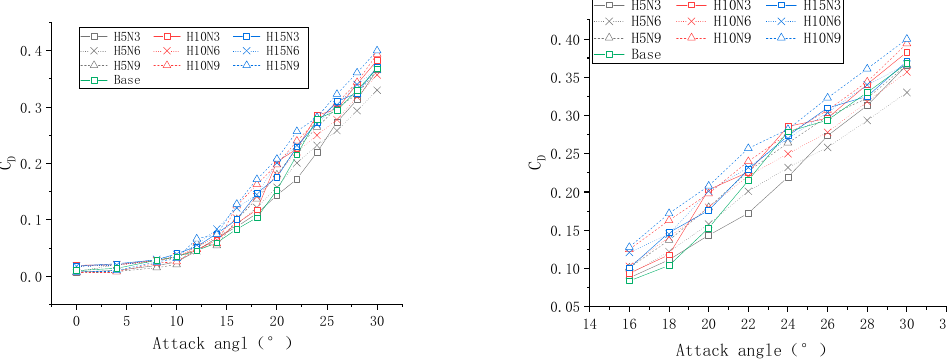
Figure 8. Comparison of Drag coefficients between the base blade and blades with tubercles.